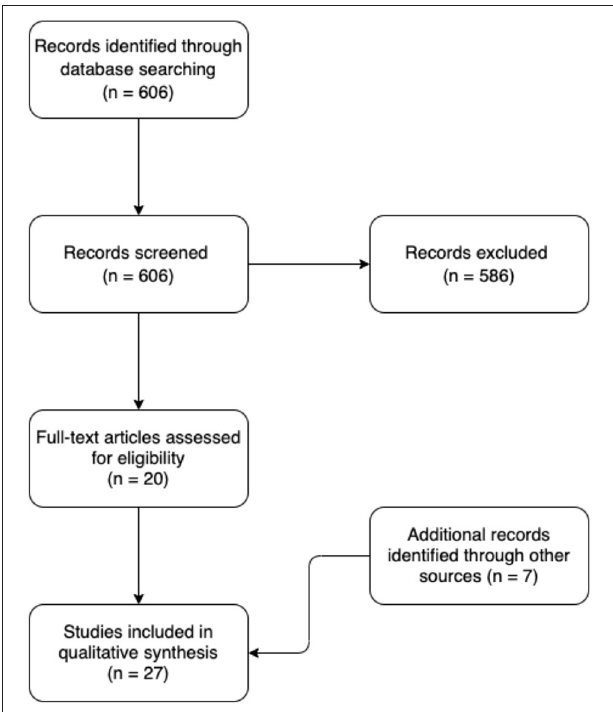
FIGURE 2 | Flow diagram of the literature